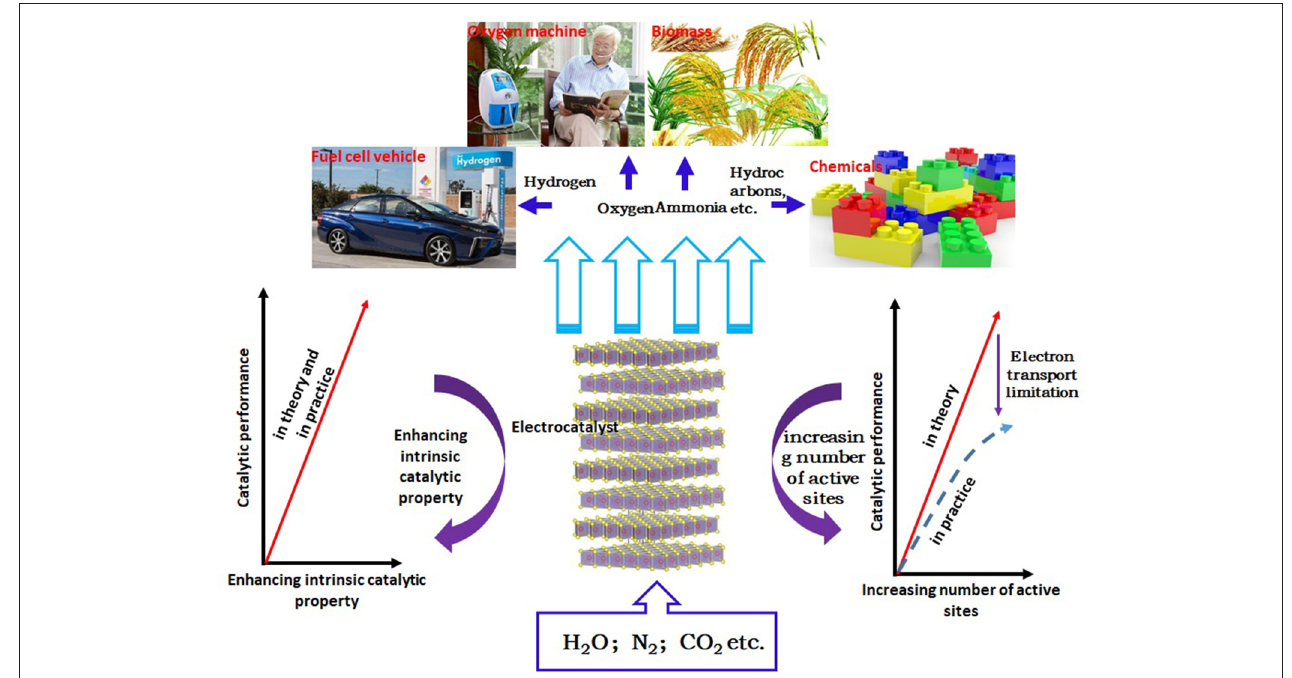
FIGURE 1 | Schematic diagram of sustainable energy pattern and catalyst development strategies based on the